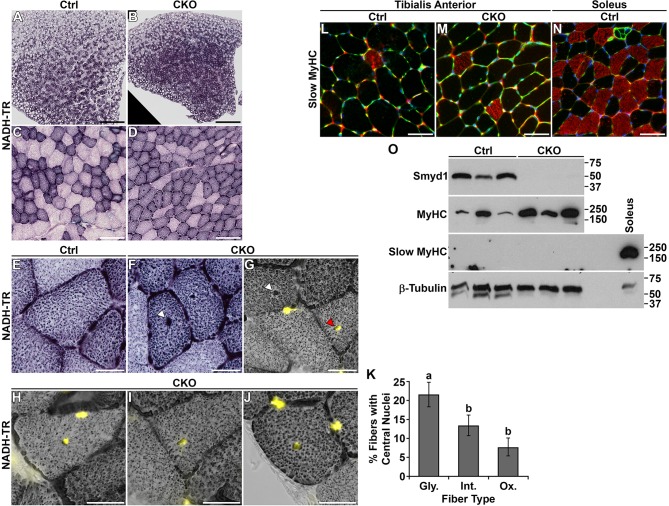
Smyd1 CKO mice exhibited increased numbers of oxidative myofibers. (A-J) NADH-TR staining of the tibialis anterior. Smyd1 CKOs had more fibers with intense oxidative stain (A-D). The only intermyofibrillar network irregularity observed was a central dense focus of oxidative stain (E-G). The dense foci frequently correlated with centralized nuclei [yellow, nuclei (DAPI); white arrowhead, foci of oxidative stain; red arrowhead, foci of oxidative stain that colocalizes with a central nucleus] (G). Centralized nuclei were observed in glycolytic (H), intermediate (I) and oxidative (J) fibers. (K) Centralized nuclei were most abundant in glycolytic fibers (CKOs only, n=5). Fibers were classified as glycolytic (Gly.), intermediate (Int.) or oxidative (Ox.) based on staining intensity. (L-N) There was no difference in the percentage of type I fibers in the tibialis anterior of control (L) and CKO (M) mice. Soleus was used as a positive control (N). Red, slow MyHC; green, sarcolemma (WGA-488); blue, nuclei (DAPI). (O) Western blots using extracts of tibialis anterior (one animal/lane). SMYD1 protein was undetectable in CKO muscle. Total MyHC increased in the CKO. Slow MyHC was undetectable in both control and CKO tibialis anterior; soleus was included as a positive control. Scale bars: 500 μm (A,B), 100 μm (C,D), 25 μm (E-J) and 50 μm (L-N). All data were obtained from 6-week-old males. Statistics were ANOVA+post-hoc tests. Significant differences (P<0.05) are denoted by the lowercase letters above each bar. Error bars show s.e.m. Ctrl, control; CKO, conditional knockout; MyHC, myosin heavy chain.